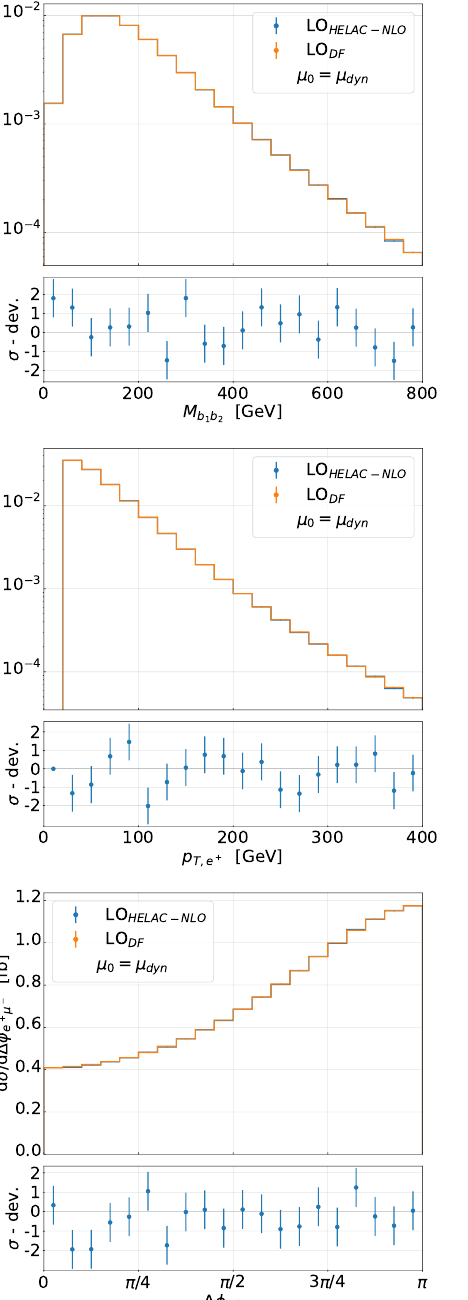
, p and ∆ φ at LO and NLO T,e + e + µ − √ 1 b 2 s = 13 TeV. Results are evaluated